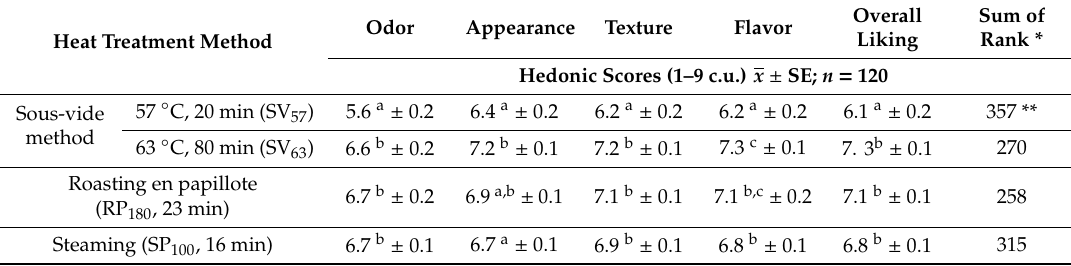
Table 4. Hedonic scores of salmon fillet processed with various heat treatment methods in the opinion of consumers.